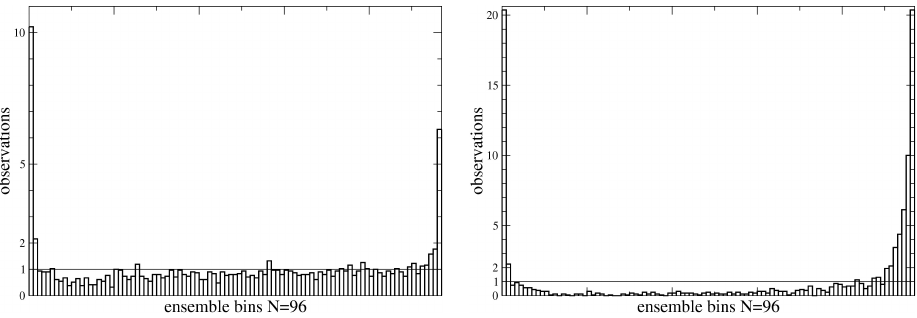
Figure 5. Global rank histogram of 0–200m layer for temperature (left panel) and salinity (right panel); same period and same area as in Fig.